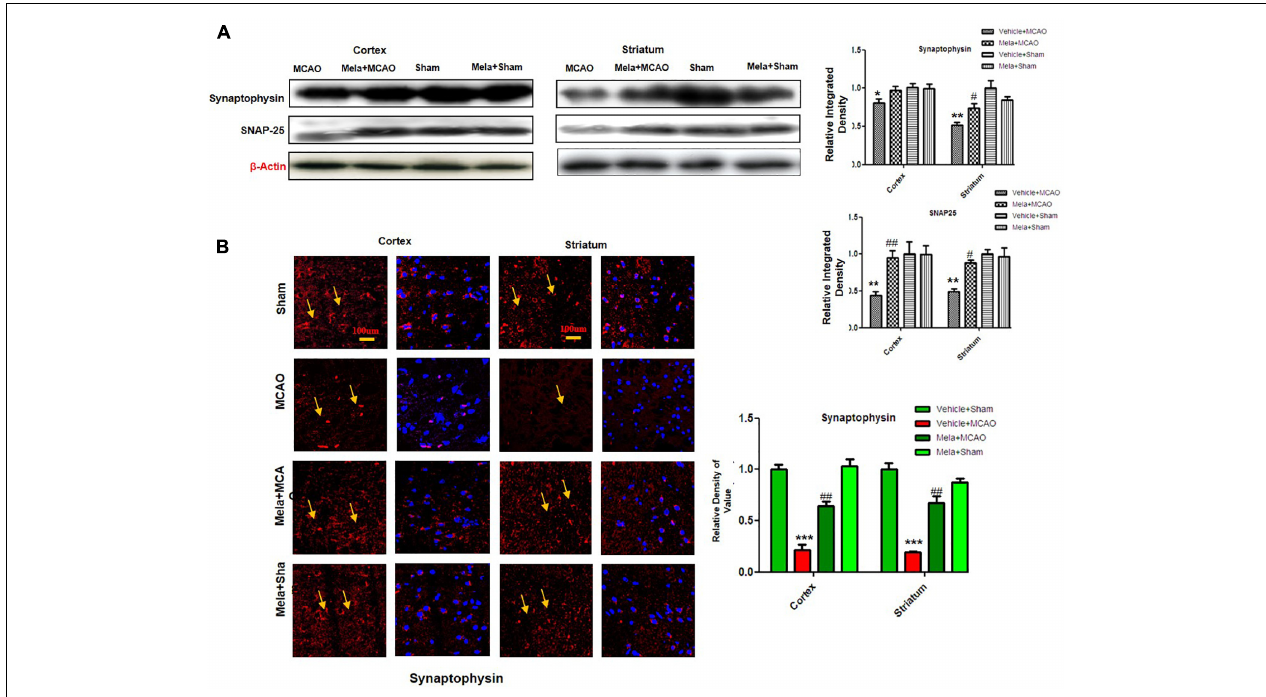
FIGURE 3 | Melatonin protects synaptic protein from ischemic injury. (A) Western blot analysis of SNAP-25 and synaptophysin from ischemic cortex and striatum of vehicle-treated MCAO, melatonin-treated MCAO animals, sham-operated control group, and melatonin treated sham group ( n = 7 rats per group). The bands were quantified using ImageJ, analyzed by graph-pad prism-5 software. β -actin was used as control. Densitometric analysis was expressed in arbitrary units as the mean ± SEM for the indicated proteins. (B) Immunofluorescence reactivity of synaptophysin; ( n = 7 rats/group). The above data is representation of 3 numbers of experiments. Scale bar = 100 µ m and magnification 40 × . Synaptophysin was visualized by Alexa-Flour 594. Symbols ∗ or # represent significant difference values p < 0.05, while symbols ∗∗ and ## represent p < 0.01 values for significant differences, symbol ∗∗∗ shows p < 0.001. Symbols ∗ shows significant difference relative to sham control while # shows significant difference relative to